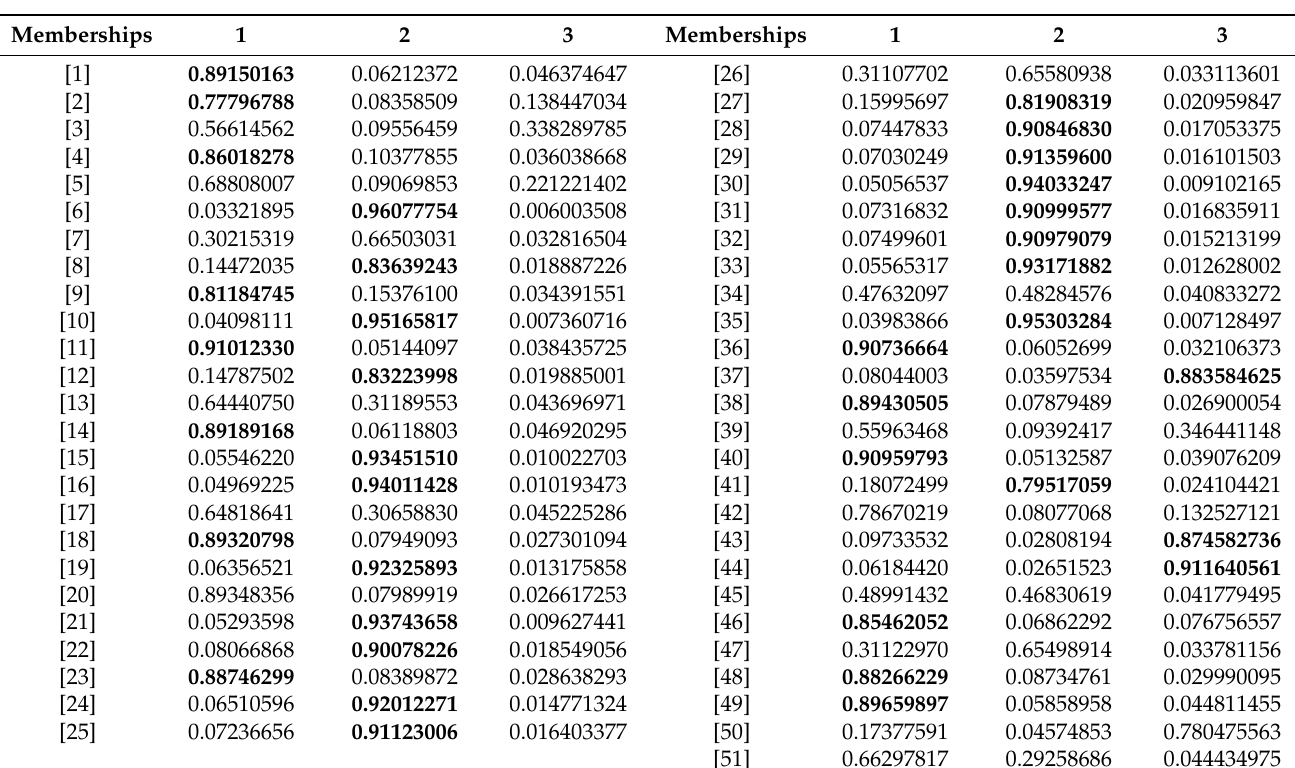
Figure 9. Results of clustering using k-means. Table 1. Results of fuzzy